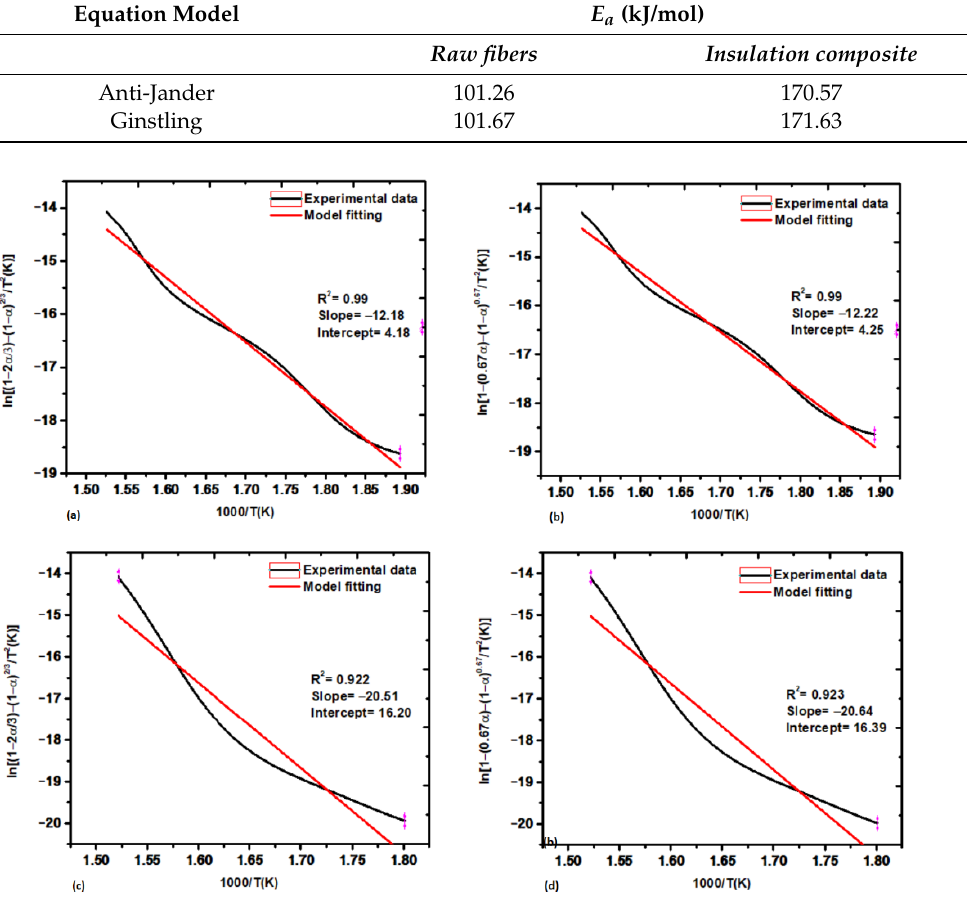
Figure 12. Fitted diffusion models. ( a ) The anti-Jander model for raw fibers, ( b ) the Ginstling model for raw fibers, ( c ) the anti-Jander model for insulation composite, and ( d ) the Ginstling model for the insulation composite.